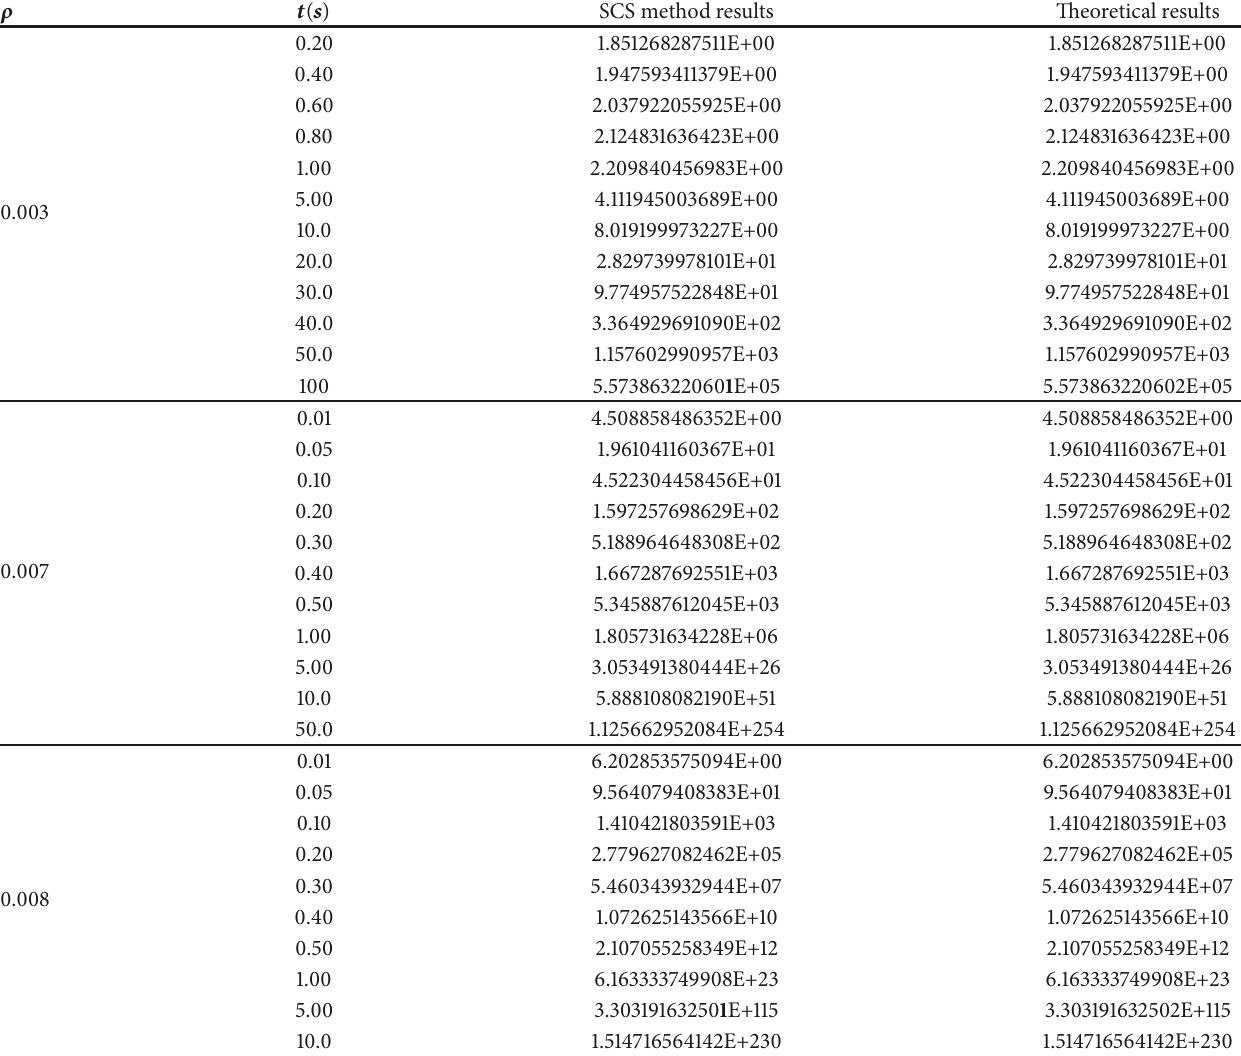
Table 2: Comparison of the exact and SCS results for test case 1 of step reactivity